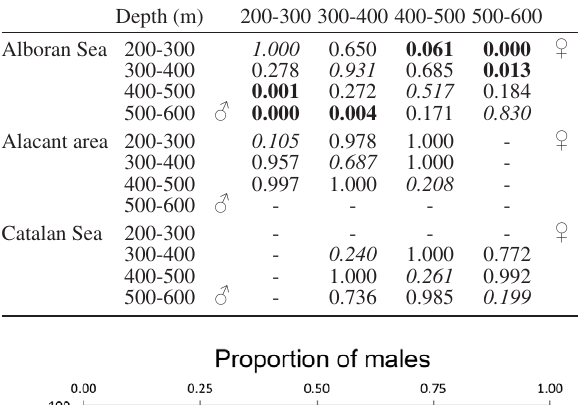
Table 4. – Comparison of size frequency distributions by 100 m depth strata within each geographic population. The Kolmogorov- Smirnov p values for the comparison between females are presented above the diagonal, between males below the diagonal, and between genders along the diagonal (values in italics); significant values are shown in bold.